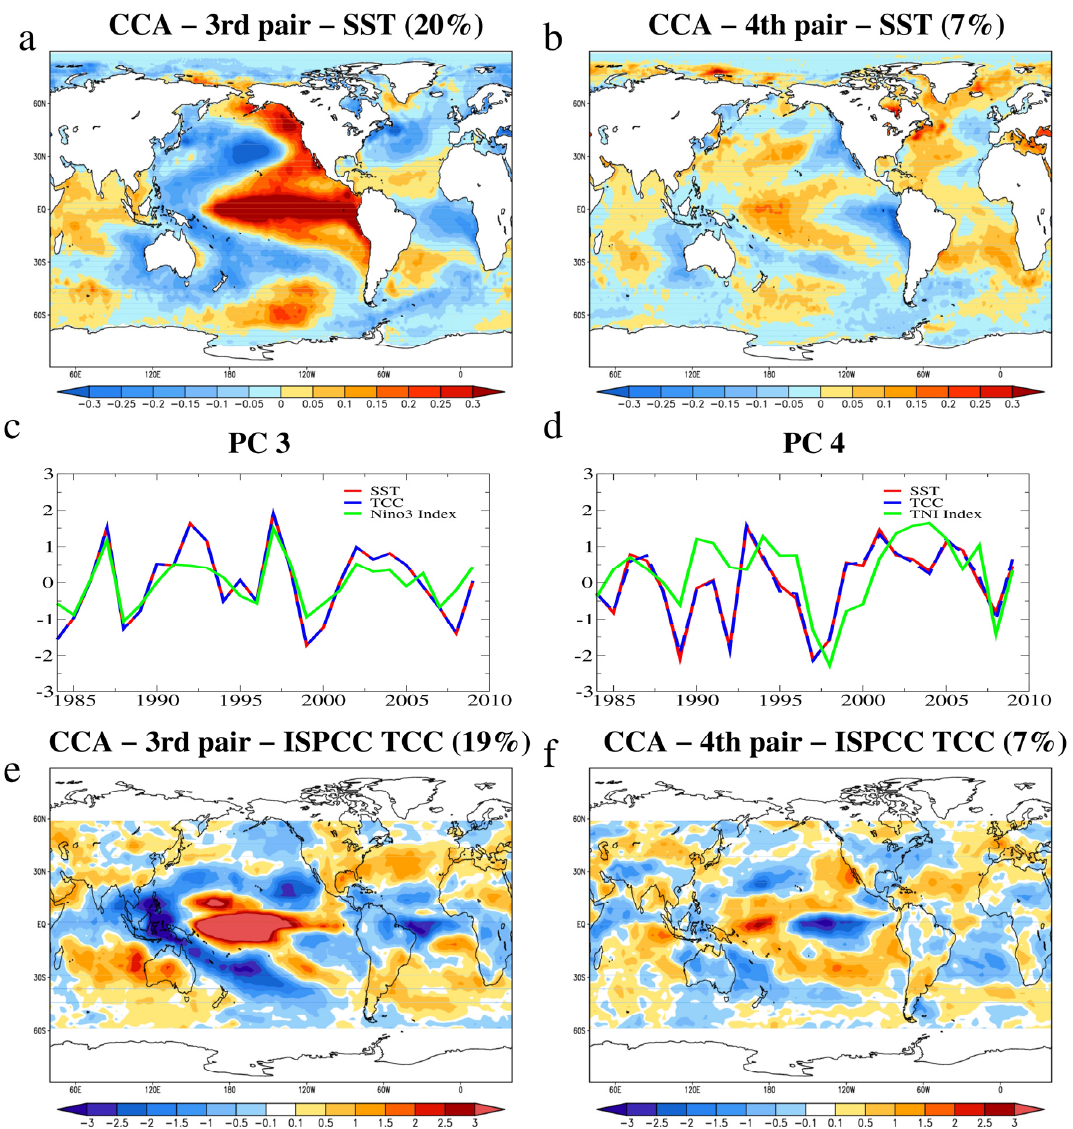
Figure 2. The EP ENSO and the CP ENSO footprints on global SST–TCC coupled fields, identified through CCA using ISPCC TCC data on the 1984–2009 period. The left column shows the third coupled SST (°C)—TCC (%) pair, the SST pattern ( a ), explaining 20% of variance, the TCC structure ( e ), explaining 19% of variance and the time series ( c ) associated with TCC (blue line) and SST (red line). The correlation with the Niño3 index (green line) is 0.81. The right column shows the fourth coupled SST (°C)—TCC (%) pair, the TCC pattern ( b ), explaining 7% of variance, the SST structure ( f ), explaining 7% of variance, and the time series( d ) associated with TCC (blue line), and SST (red line). The correlation with the TNI Index (green line) is